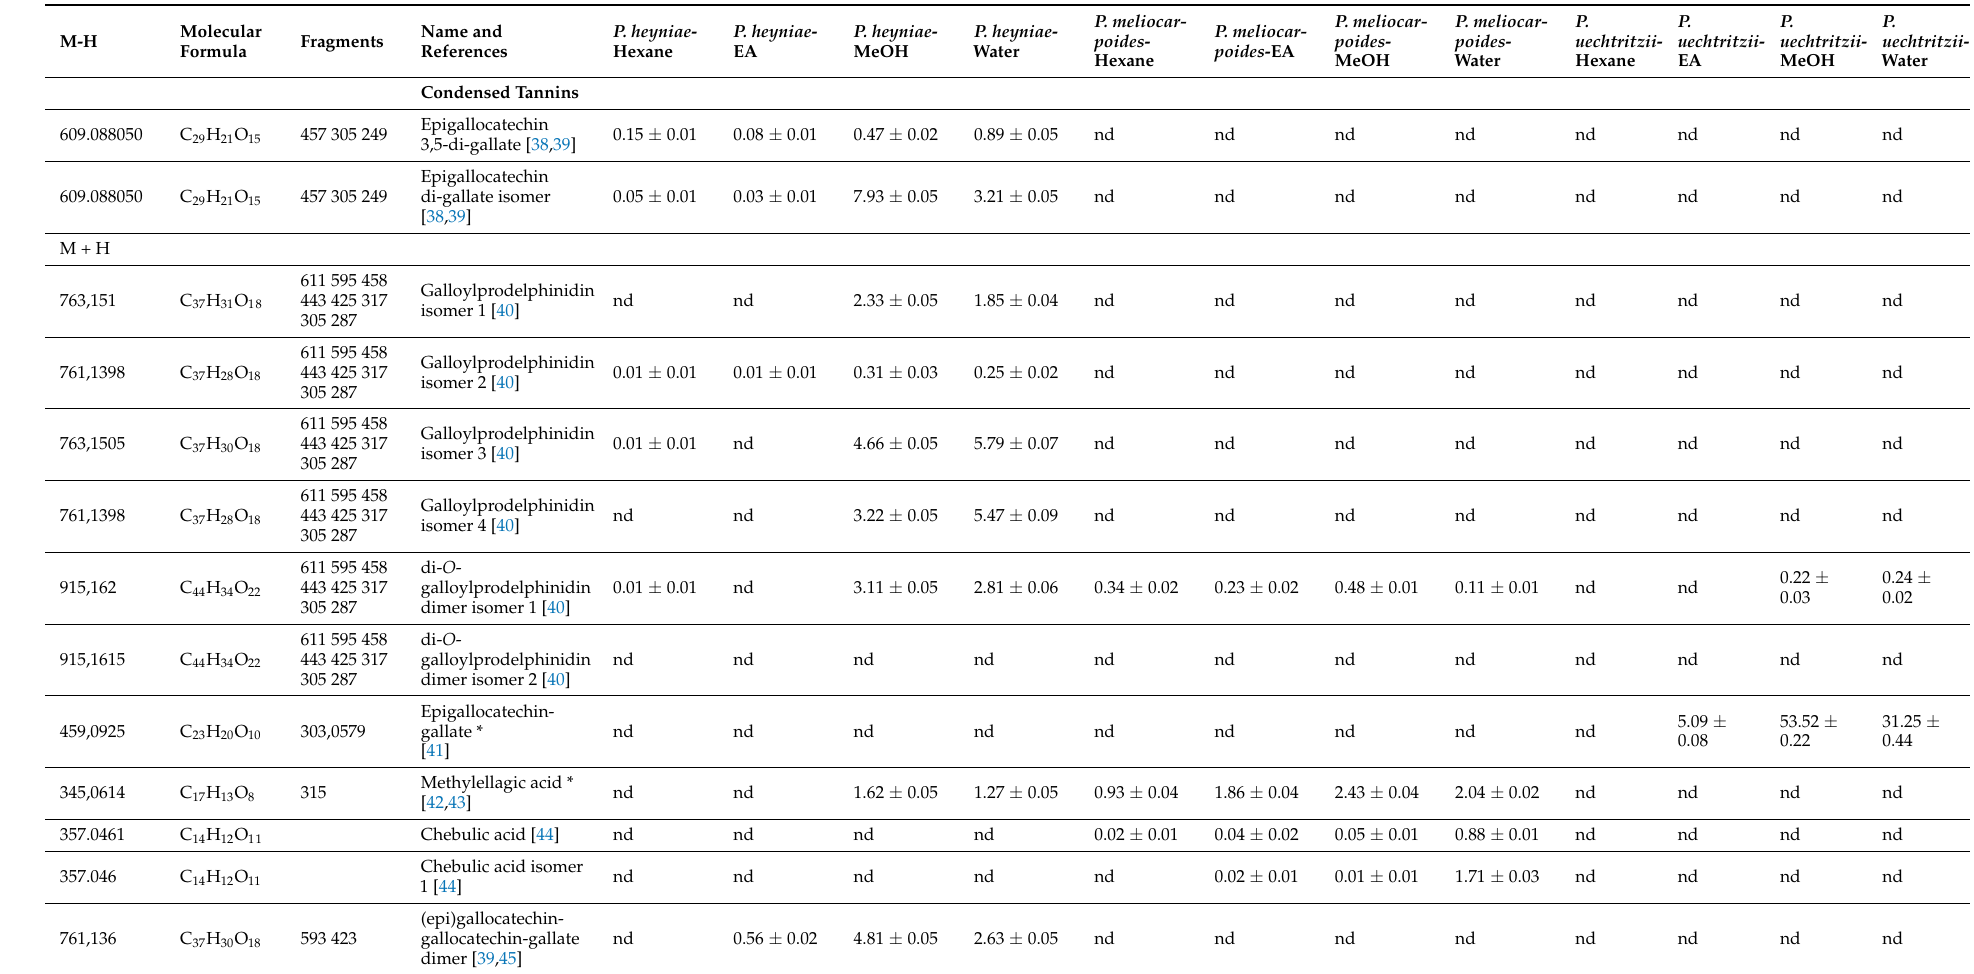
Table 2. Chemical composition of the tested extracts in positive and negative ion mode